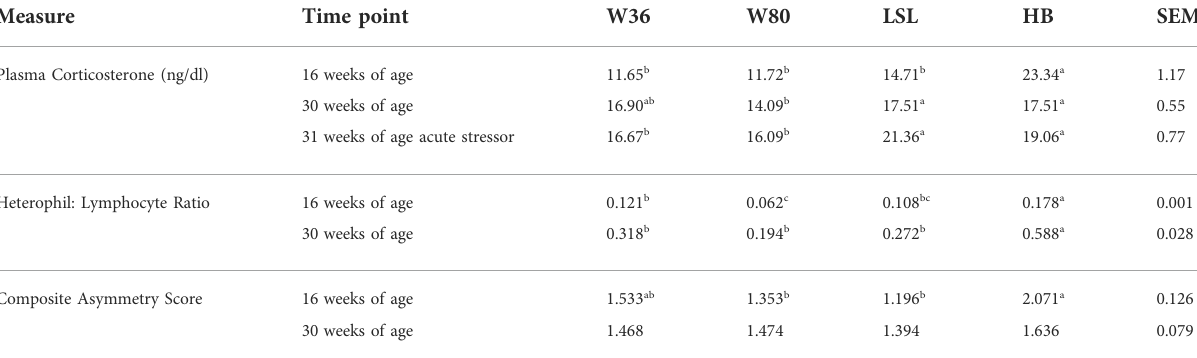
TABLE 2 Stress susceptibility measures of four commercial strains of layer chickens (W36, W80, LSL, and Hy-Line Brown (HB)) at 16 and 30 weeks of age and after an acute stress test.